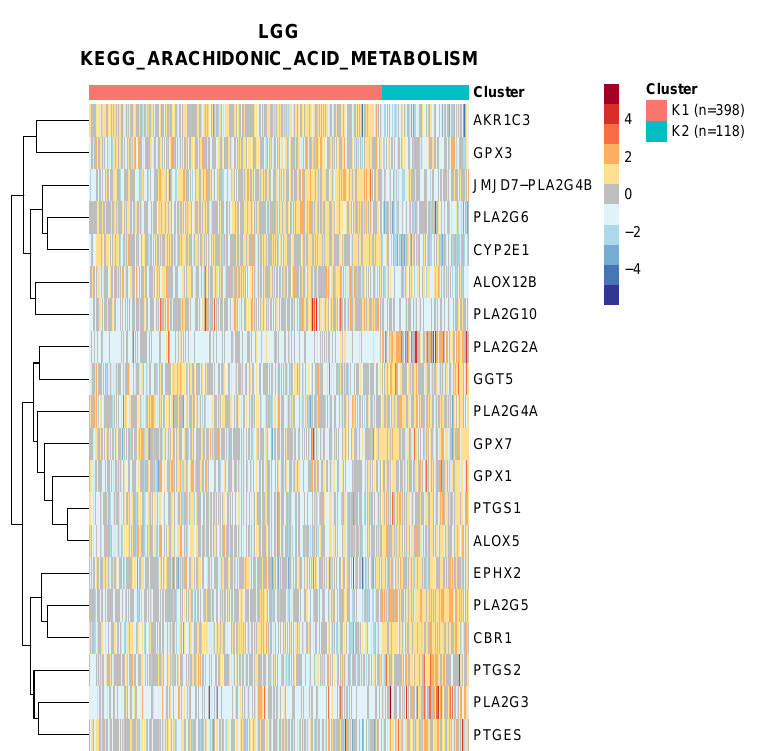
Figure 1. Clustering of low-grade glioma patients using the genes involved in arachidonic metabolism according to KEGG. Only the 20 genes most differentially expressed between the two clusters are